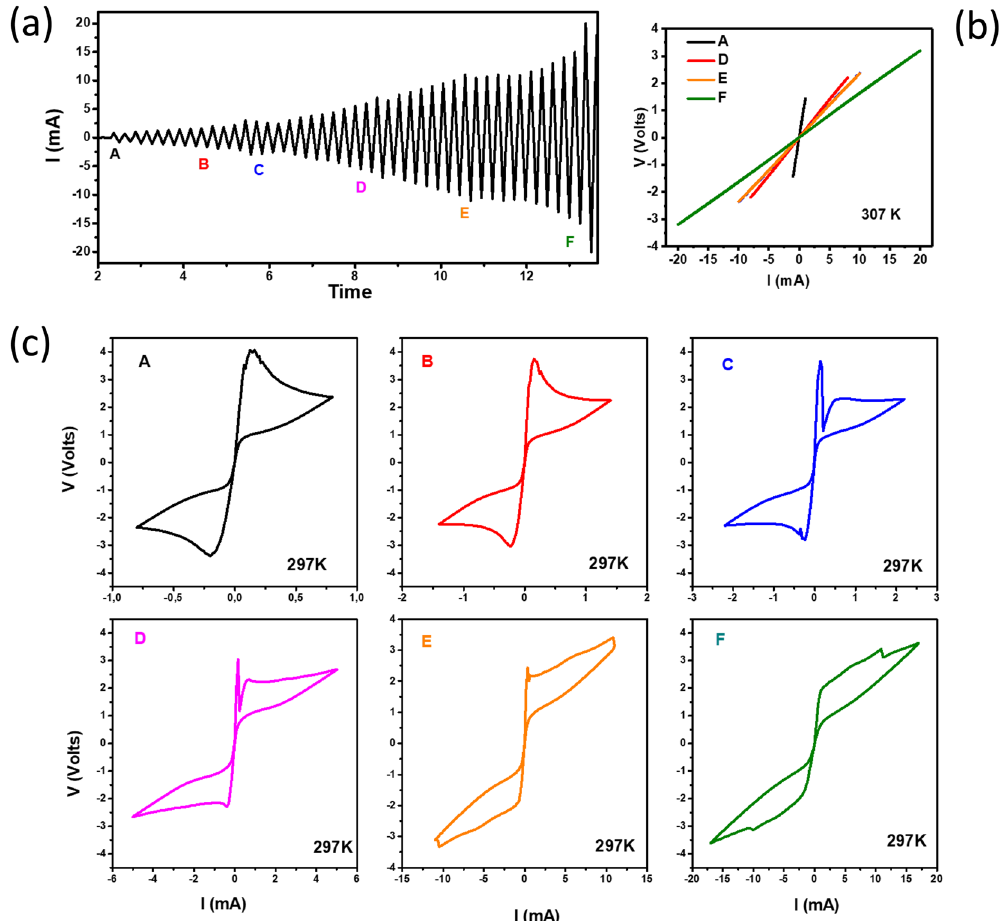
Figure 5. ( a ) Current bias applied to the sample; the labels A, B, C, D, E, F indicate the current range for each graph shown in figure ( b ) at 307 K and ( c ) at 297 K,